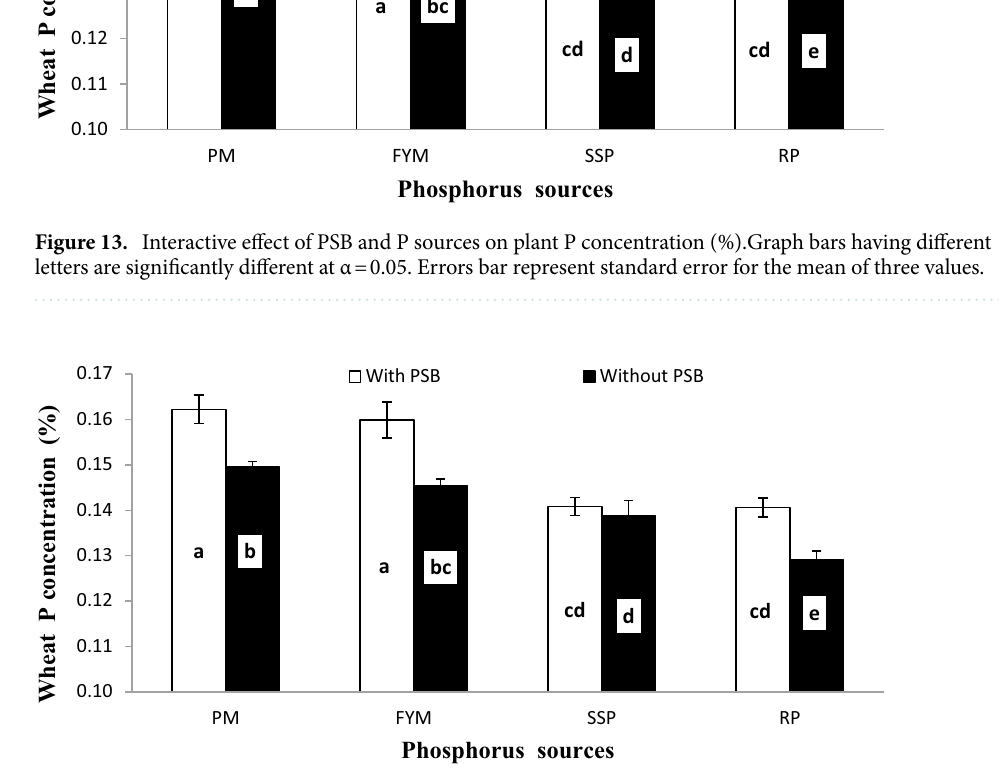
Figure 14. Interactive effect of PSB and P sources on wheat P uptake (mg kg −1 ). Graph bars having different letters are significantly different at α = 0.05. Errors bar represent standard error for the mean of three